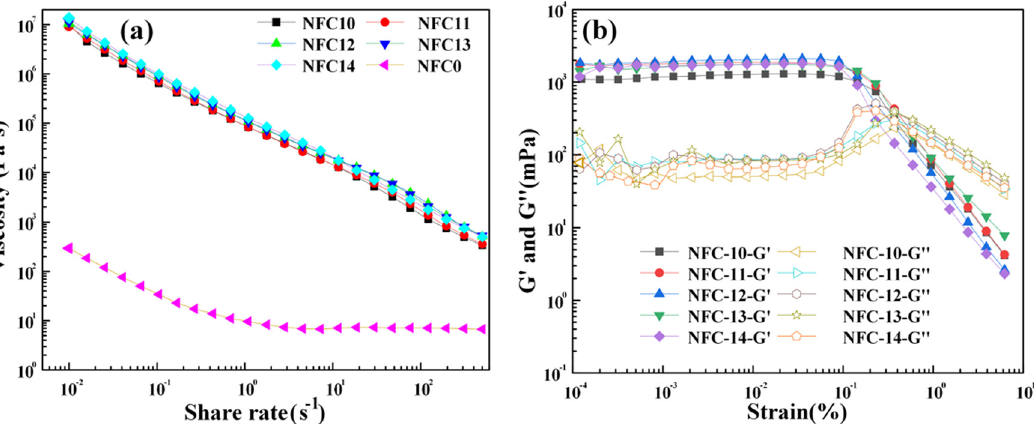
Figure 4: Rheology characteristics of ( a ) apparent viscosity and ( b ) storage modulus G ′ and loss modulus G ″ of intelligent PDMAA hydrogels with various NFC